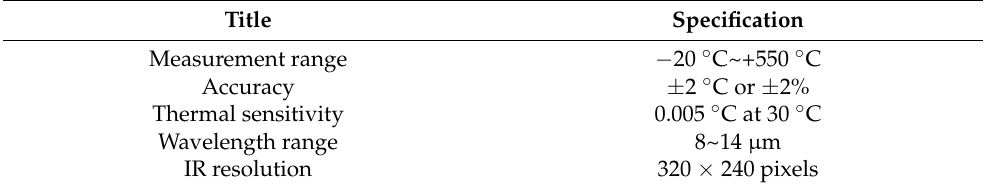
Table 1. Specification of infrared thermal imaging camera used to collect thermal bridge